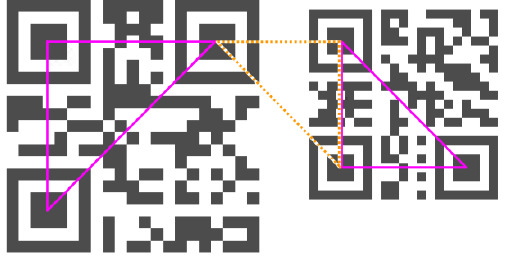
Figure 7. QR Code candidates.